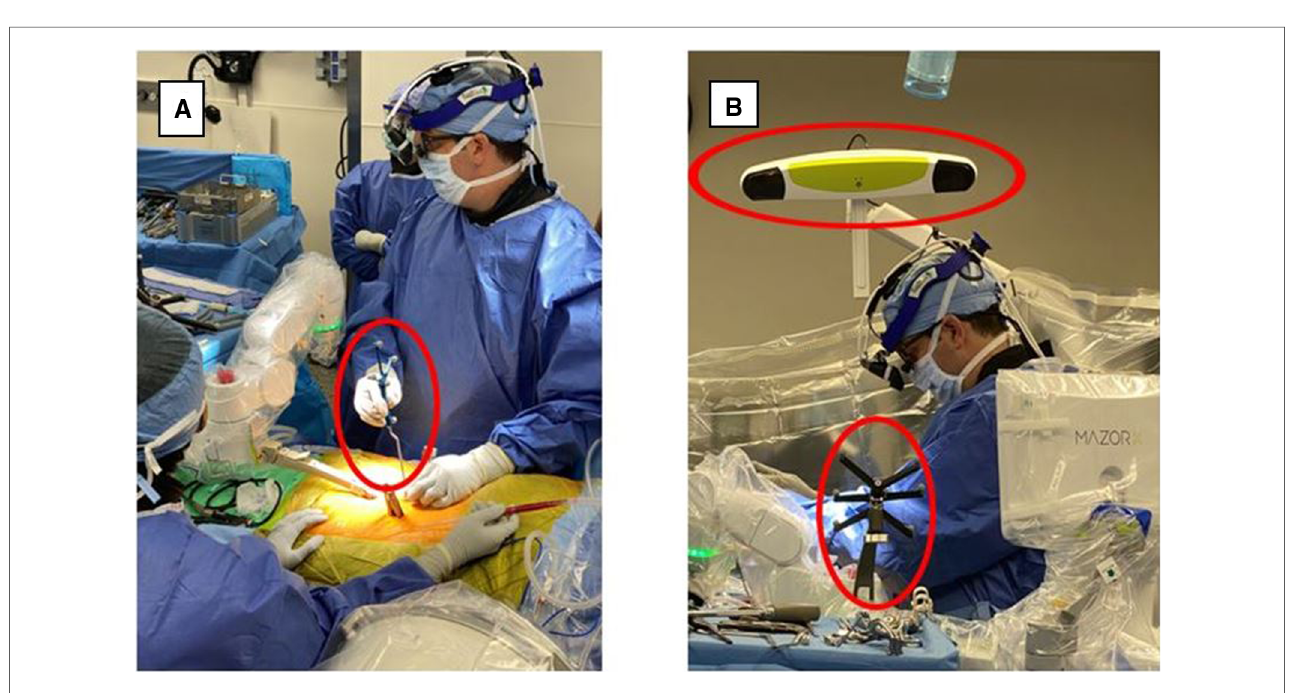
FIGURE 5 Ran registration process, all required surgical instrumentation was registered and veri fi ed via 3De fi ne cameras. RAN, robotically assisted navigation.